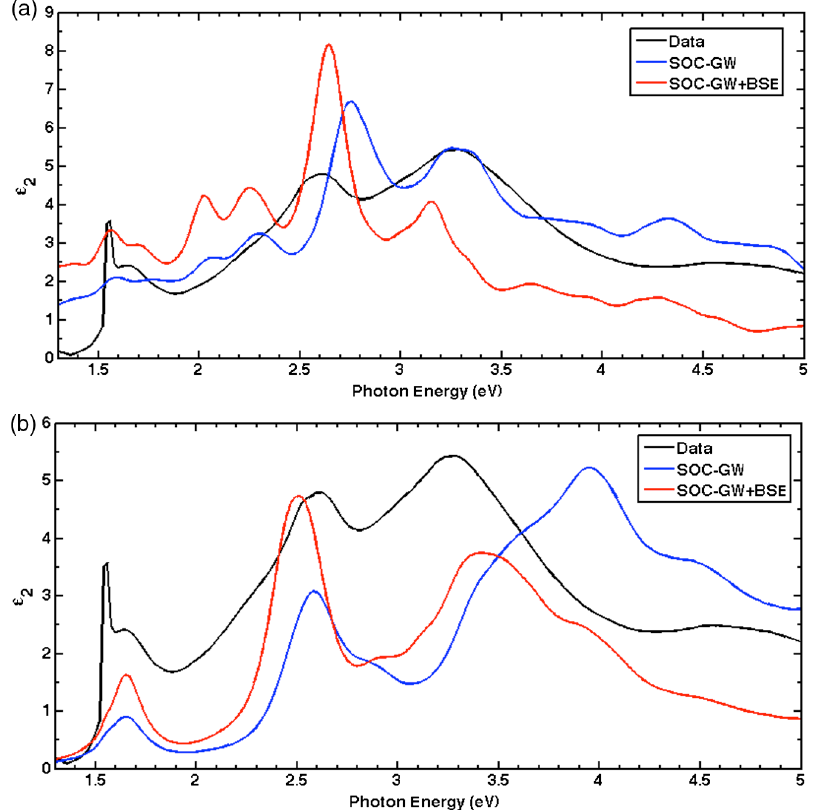
FIG. 5. Comparison of the data at 77 K with calculations of ε 2 from DFT simulations of (a) undoped FAPbI 3 and (b) FA 0 Cs 0 PbI 2 Br 0 , both with and without electron-hole interactions (BSE). Note that spin orbit coupling (SOC) is included . 85 . 15 . 9 . 1 in our